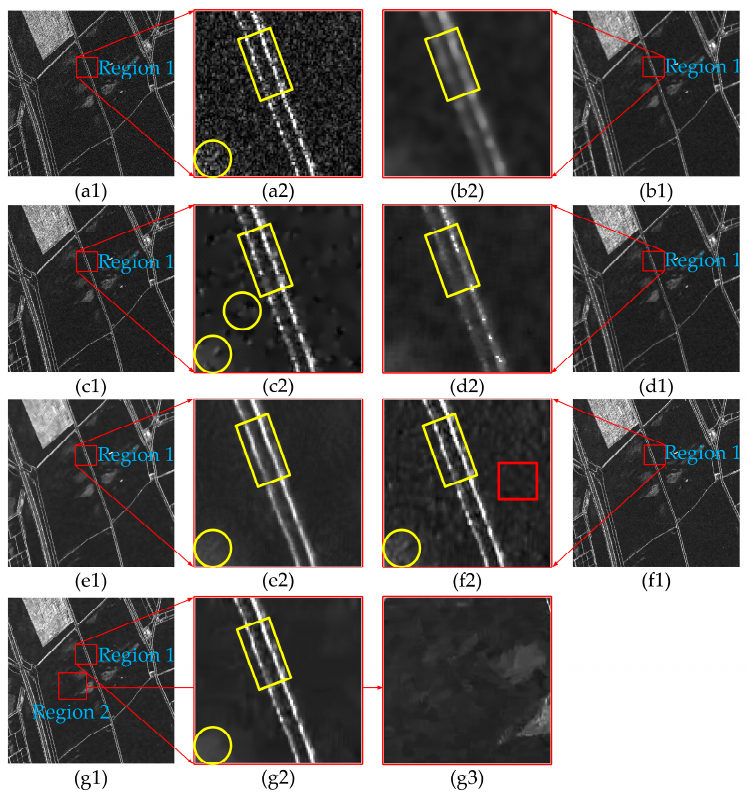
Figure 4. ( a1 ) Noisy GF-3 SAR image. Filtered images by ( b1 ) SRAD filter, ( c1 ) DPAD filter, ( d1 ) EnLee filter, ( e1 ) PPB filter, ( f1 ) SAR-BM3-D filter, and ( g1 ) FANS filter. ( a2 – g2 ) are the enlarged images of region 1 from ( a1 – g1 ). ( g3 ) is the enlarged image of region 2 from ( g1 ).